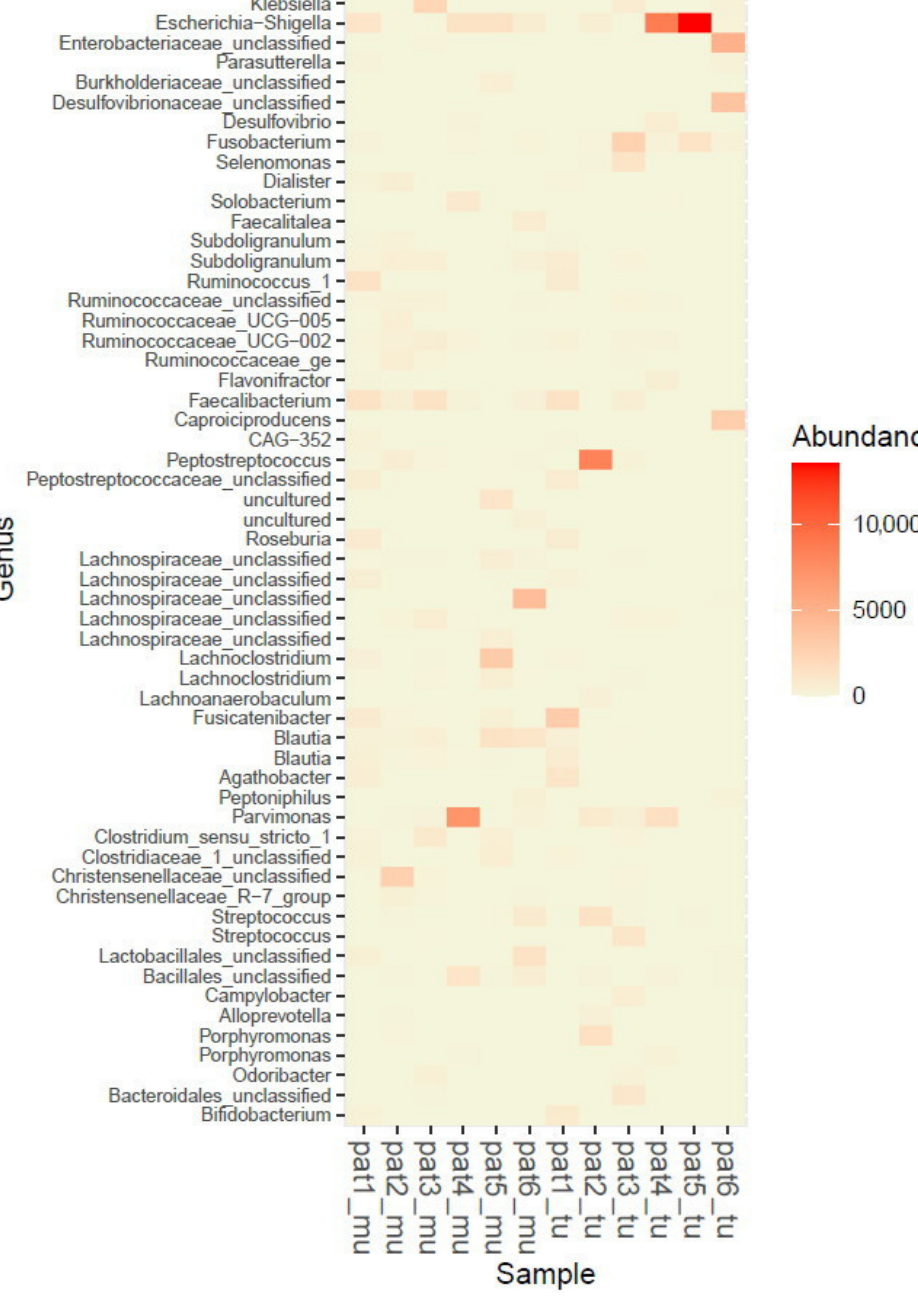
Figure 3. Heatmap of abundance at the genus level for all samples (pat = patient, mu = mucosa, tu = tumor samples).